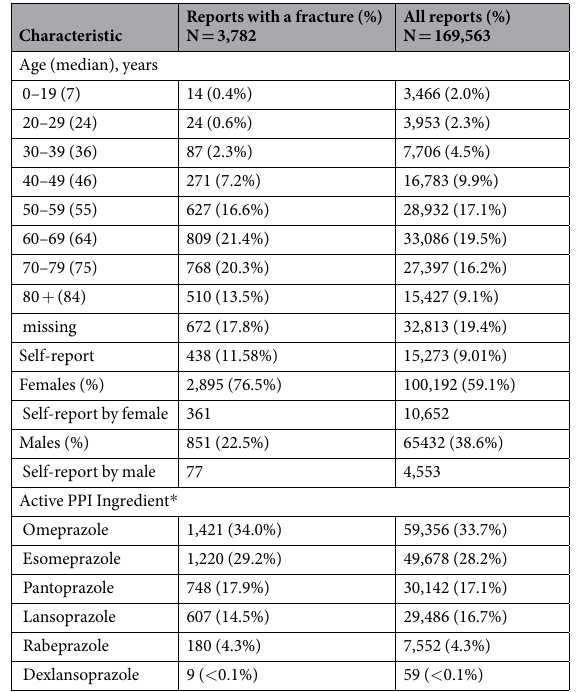
Table 1. Characteristics of the 169,563 MedDRA Adverse Event Reports involving at least one proton pump inhibitor (PPI) ingredient, comparing reports with a fracture and all reports with ADEs. * More than one generic ingredient could be reported in the